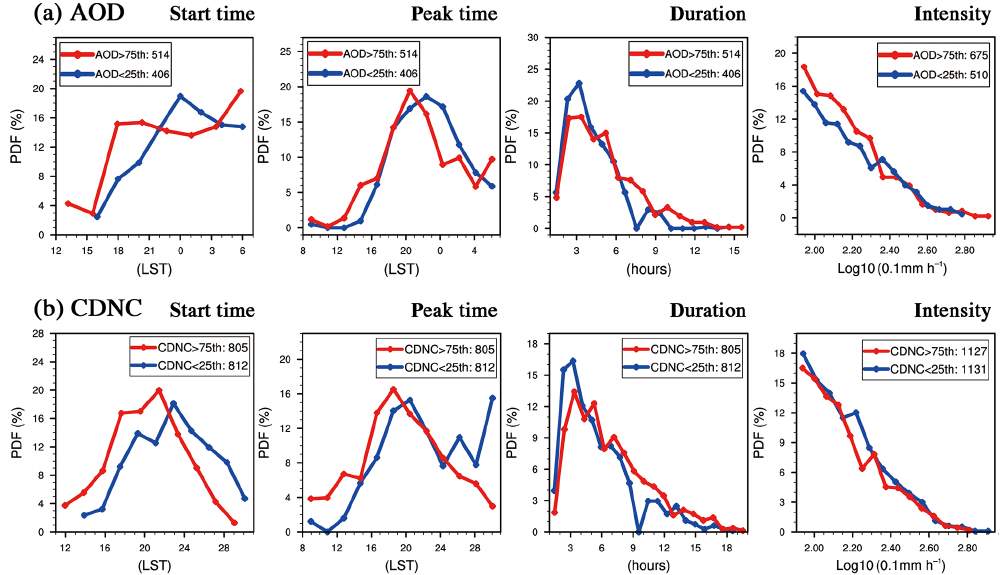
Figure 3. PDFs of start time (units: LST), peak time (units: LST), duration (units: hours) and intensity (units: 0.1mmh − 1 ) of heavy rainfall (data from CMA) on selected clean (blue lines) and polluted (red lines) conditions, respectively, using indicators of (a) AOD and (b) CDNC (cm − 3 ), during early summers from 2002 to